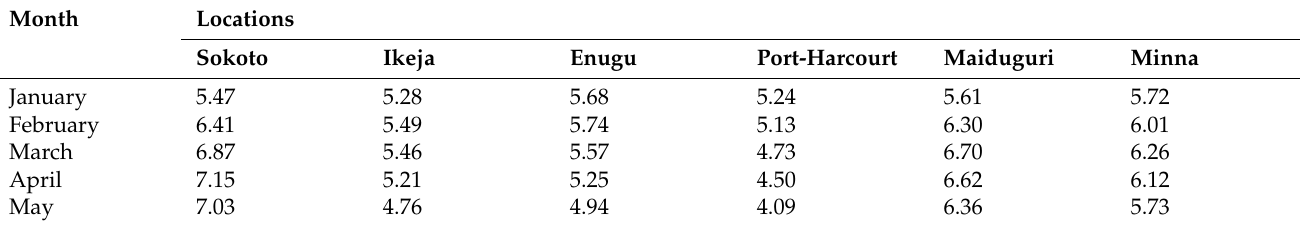
Table 6. Solar radiation data of the case study sites for EVCS (kWh/m 2 /day)